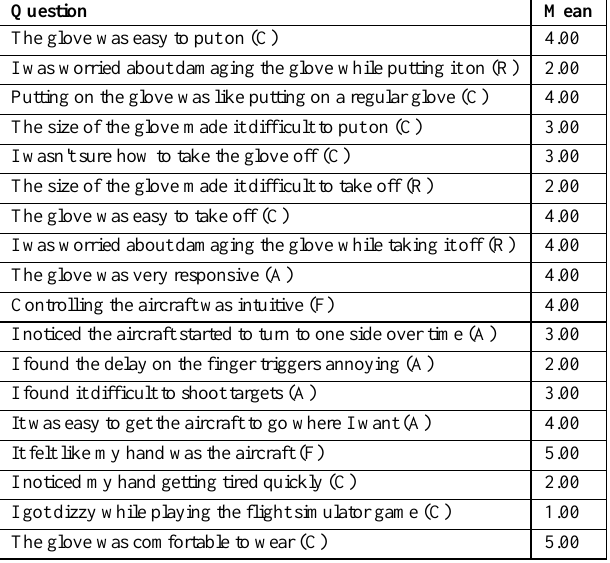
Table 3. Summary of survey responses